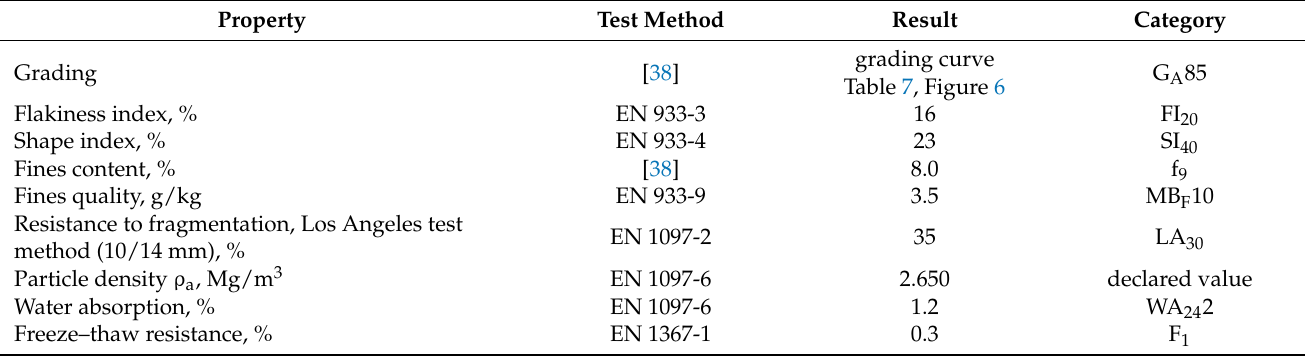
Table 8. Geometric and physical properties of reclaimed aggregate (RA) acc. EN